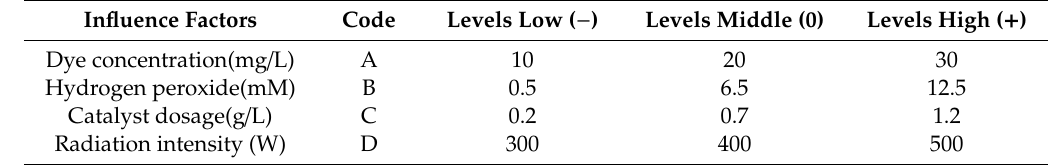
Table 1. Experimental range and levels of the independent